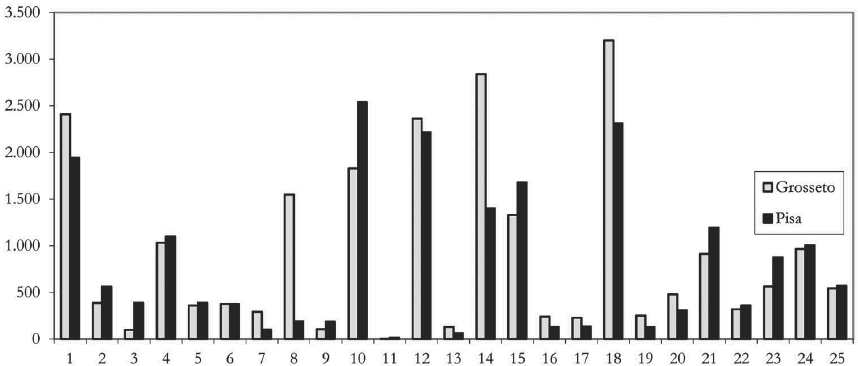
Figure 4b – Age standardized cause mortality rates (both sexes) in the provinces of Grosseto and Pisa, 1888-91 (per